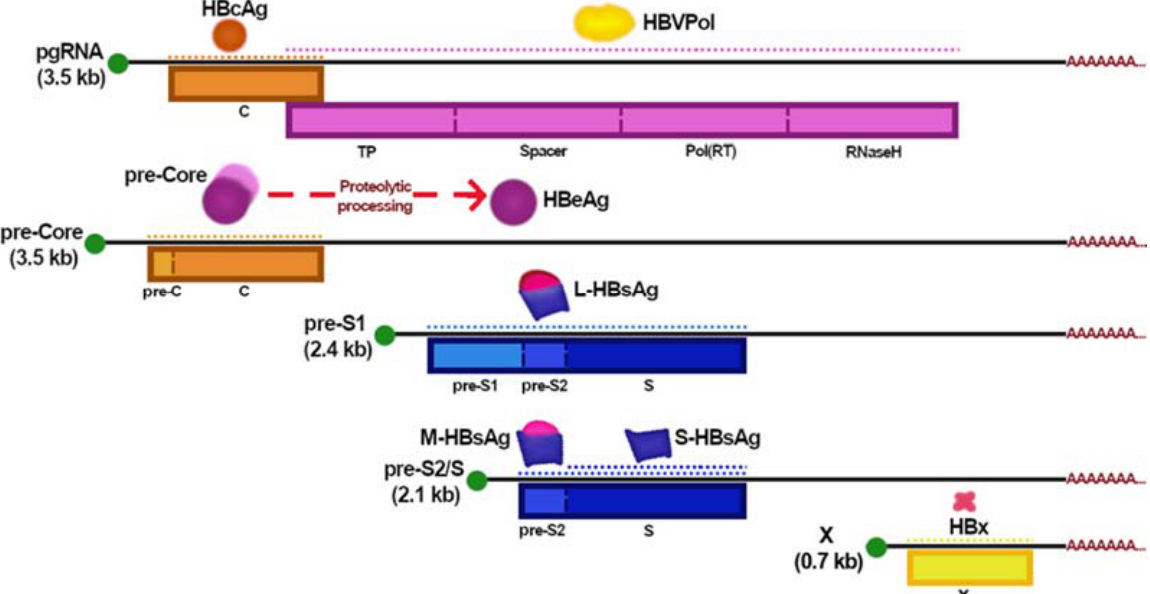
polyA tail in red; the rectangles in colors represent the ORFs while the dotted lines represent the translated segments to